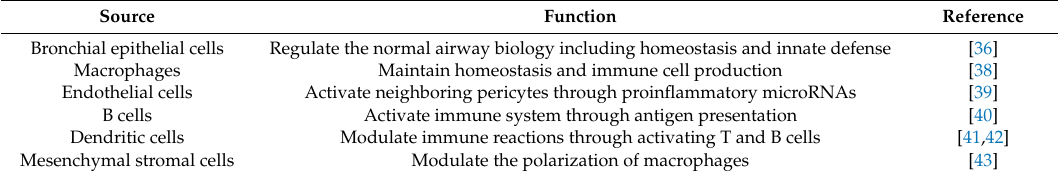
Table 1. The characteristics of extracellular vesicles in the respiratory